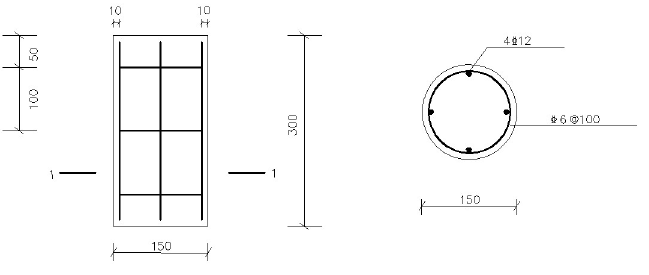
Fig 1. Dimension drawing of test